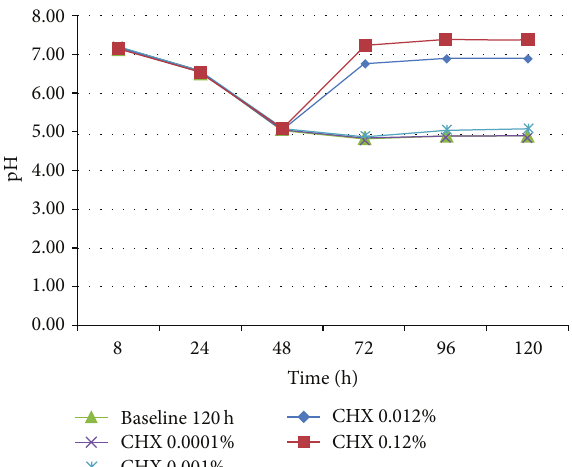
Figure 7: pH of the UTYEB culture medium after 48h of biofilm growth in the absence of treatments and at each 24 h after starting treatments (72, 96, and 120 h) ( 𝑛 = 4